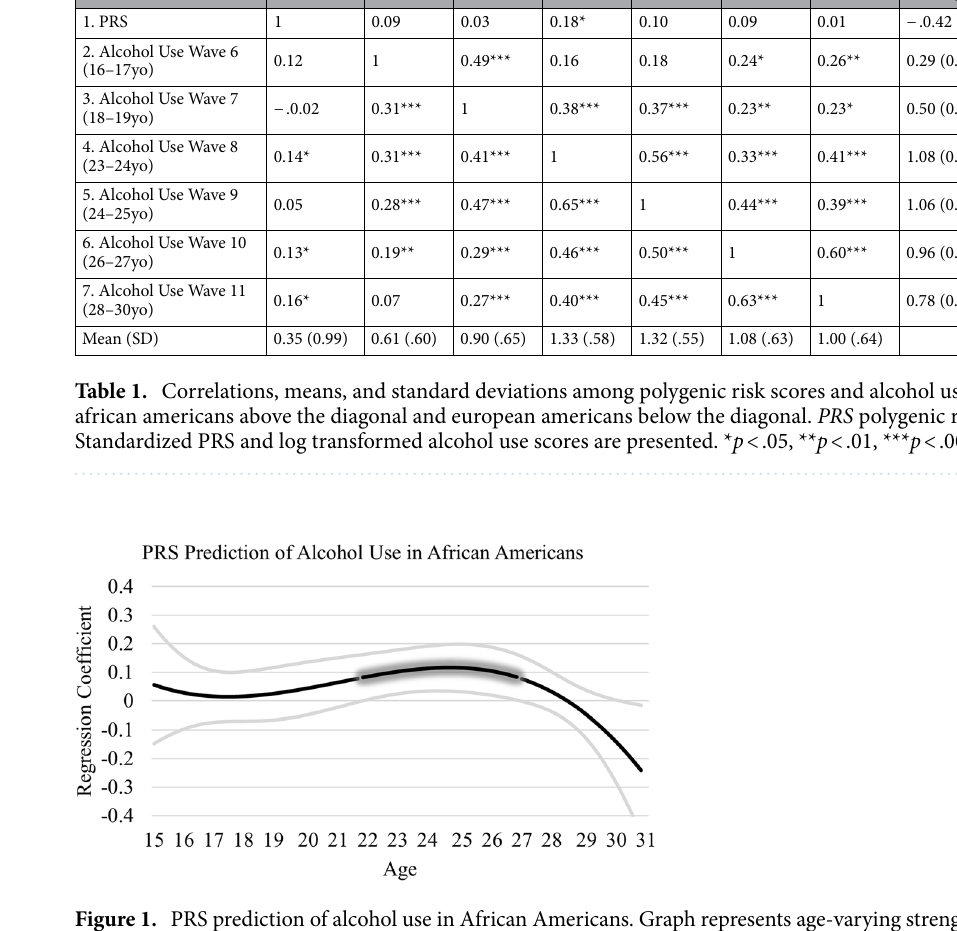
Figure 1. PRS prediction of alcohol use in African Americans. Graph represents age-varying strength of the association between the PRS and alcohol use in African Americans from 15 to 31 years of age. Regression coefficient estimates are represented by the black line and the 95% confidence interval by the gray lines. The “glowing” portion represents a significant association where the 95% confidence interval departs from zero.